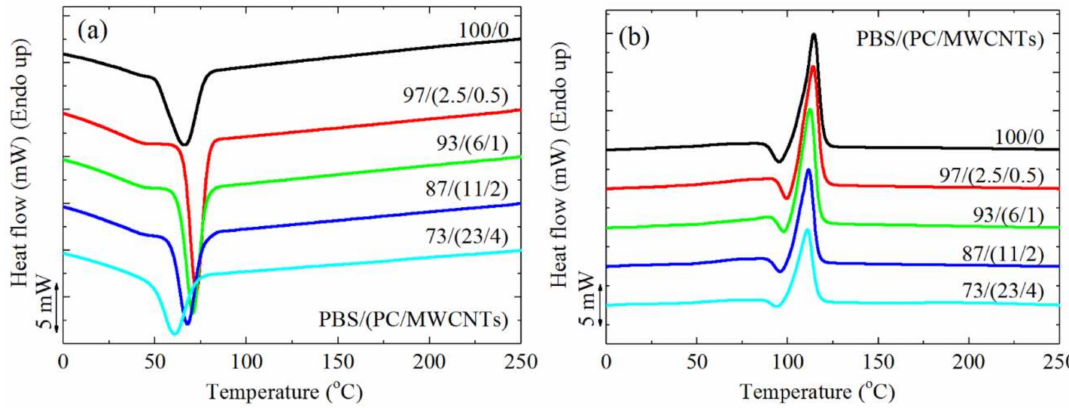
Figure 8. DSC ( a ) cooling and ( b ) second heating curves at 20 ◦ C min − 1 of neat PBS and the PBS/(PC/MWCNTs)